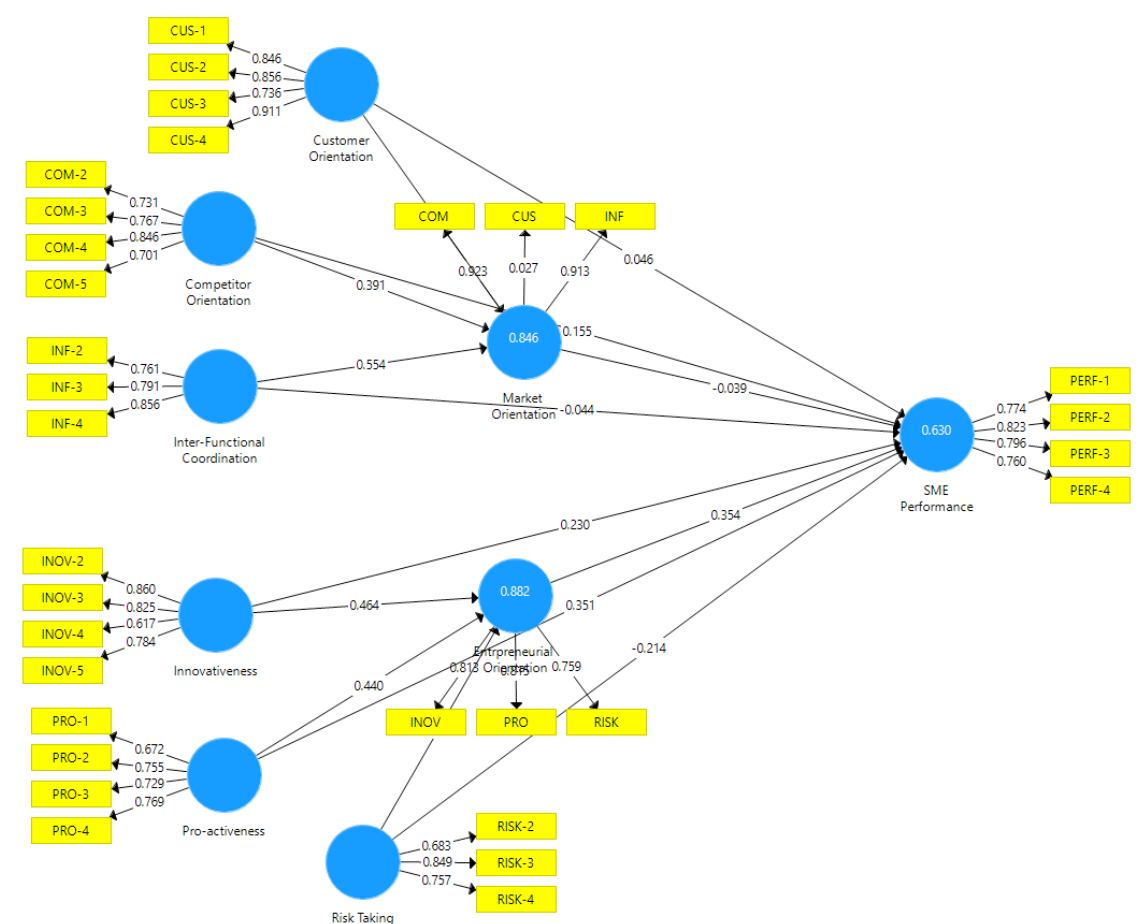
Figure 1. Structural equation model of predictors of SME performance during